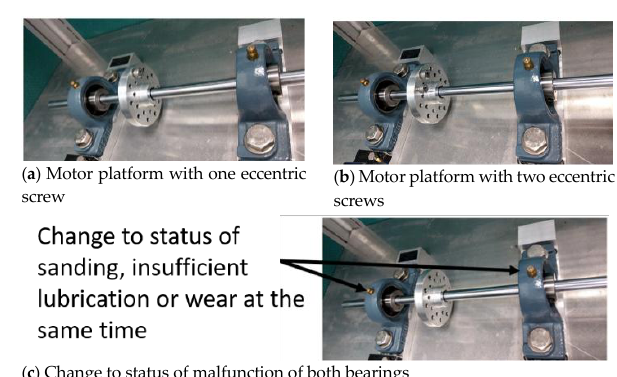
Figure 2. GUI screen.